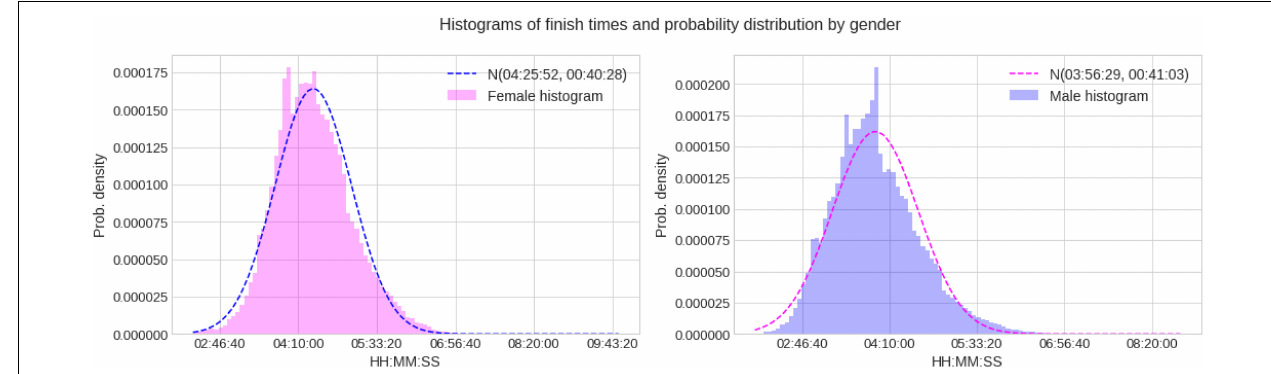
FIGURE 1 | Marathon race times histograms and probability distributions for women and men.